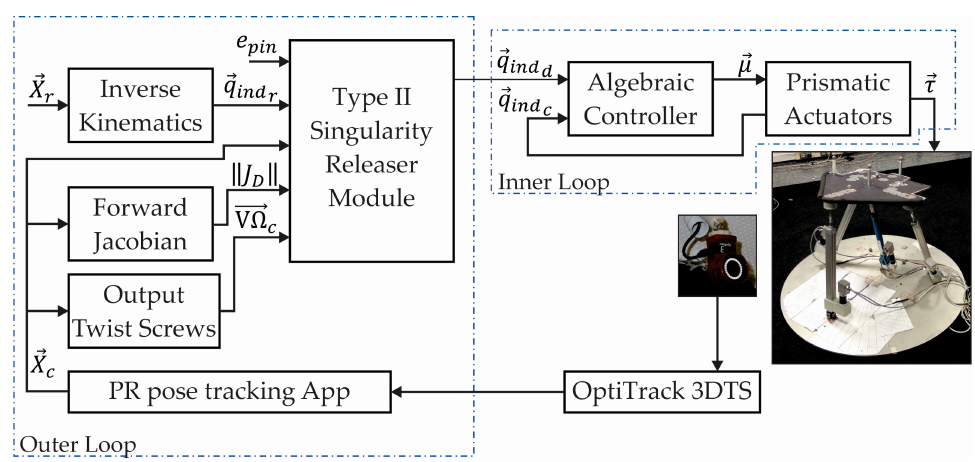
Figure 9. Hybrid controller